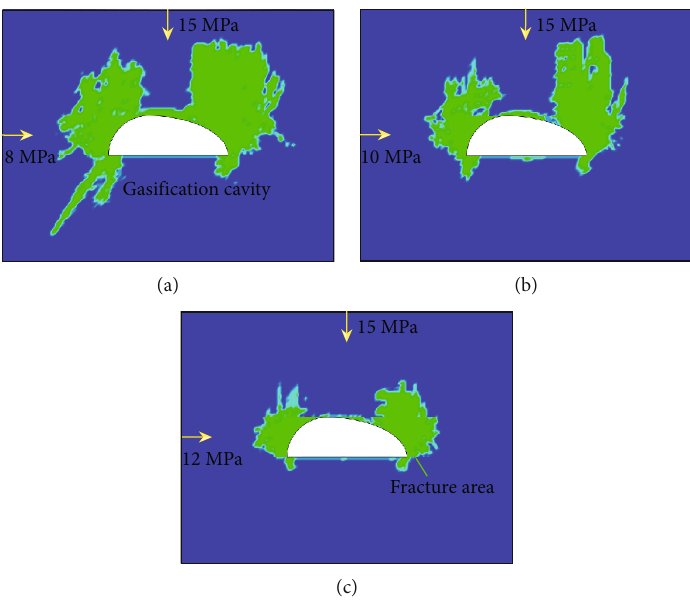
Figure 7: E ff ect of horizontal stress on the fracture area of the gasi fi cation cavity.